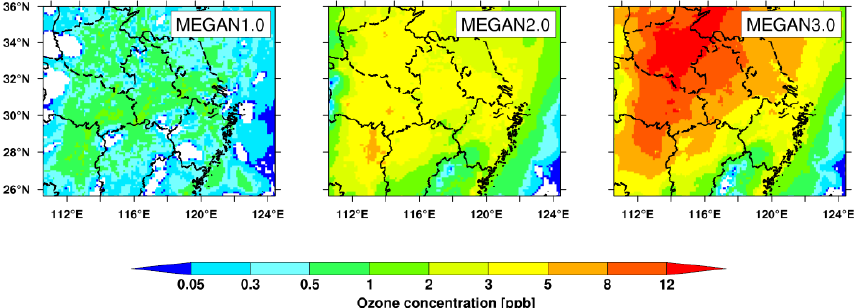
Figure 12. Spatial distribution of ozone concentration due to the biogenic emissions near the surface in July using the VEG-2015 vegetation dataset.